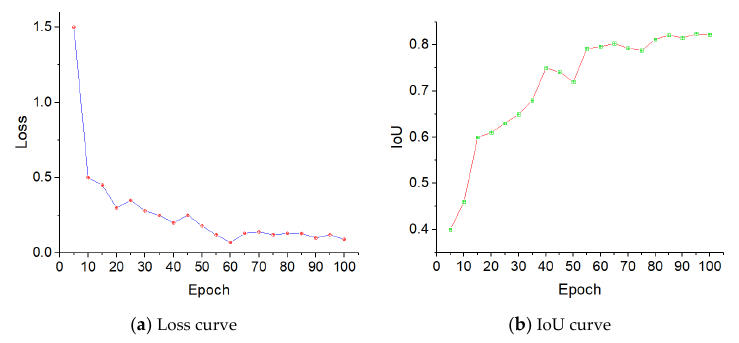
Figure 19. The Loss curve and the IoU curve with epochs.